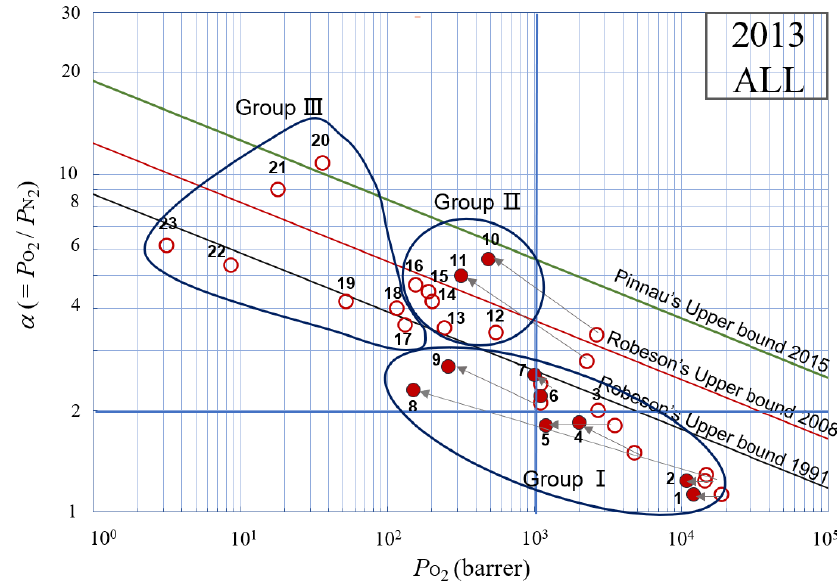
Figure 3. Plots of oxygen permselectivity through polymers, showing the highest α at each P O 2 reported in the literature until 2013 (●: after aging, ○ : before aging). For the data and categorization of the plots, see Table 1, and for the chemical structures of the polymers in the plots, see Chart 1. Table 1. Categorization and detailed data for membrane polymers in Figure 3 (All polymers until 2013). Code Polymer